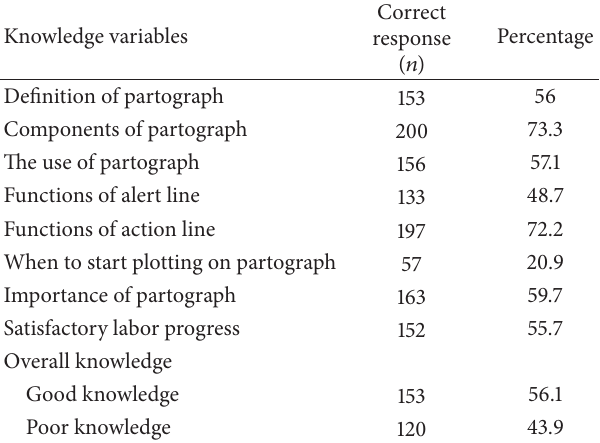
Table 4: Knowledge of obstetric caregivers on partograph and its use, East Gojjam Zone, Northwest Ethiopia, 2015 ( 𝑛 = 273